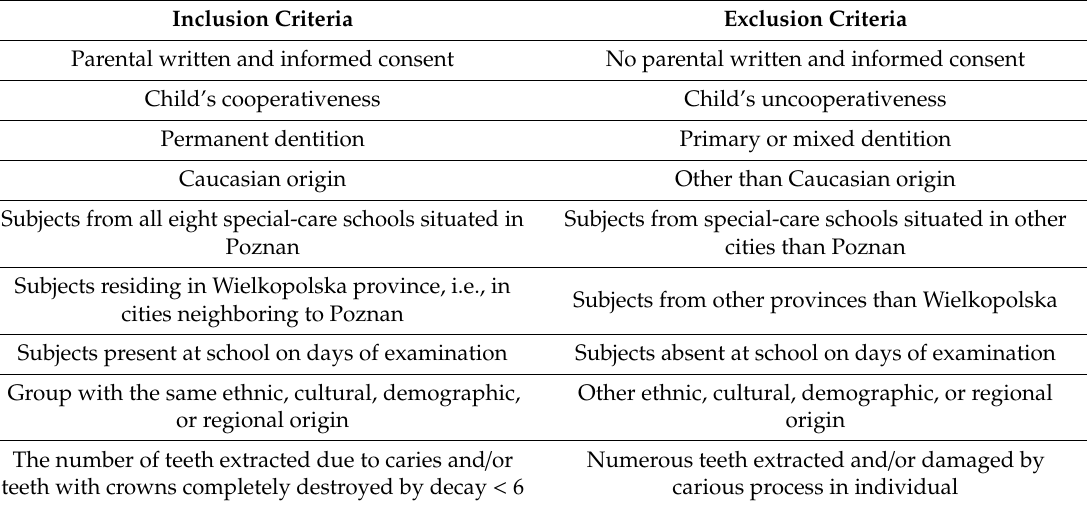
Table 1. Inclusion and exclusion criteria for the subjects in the